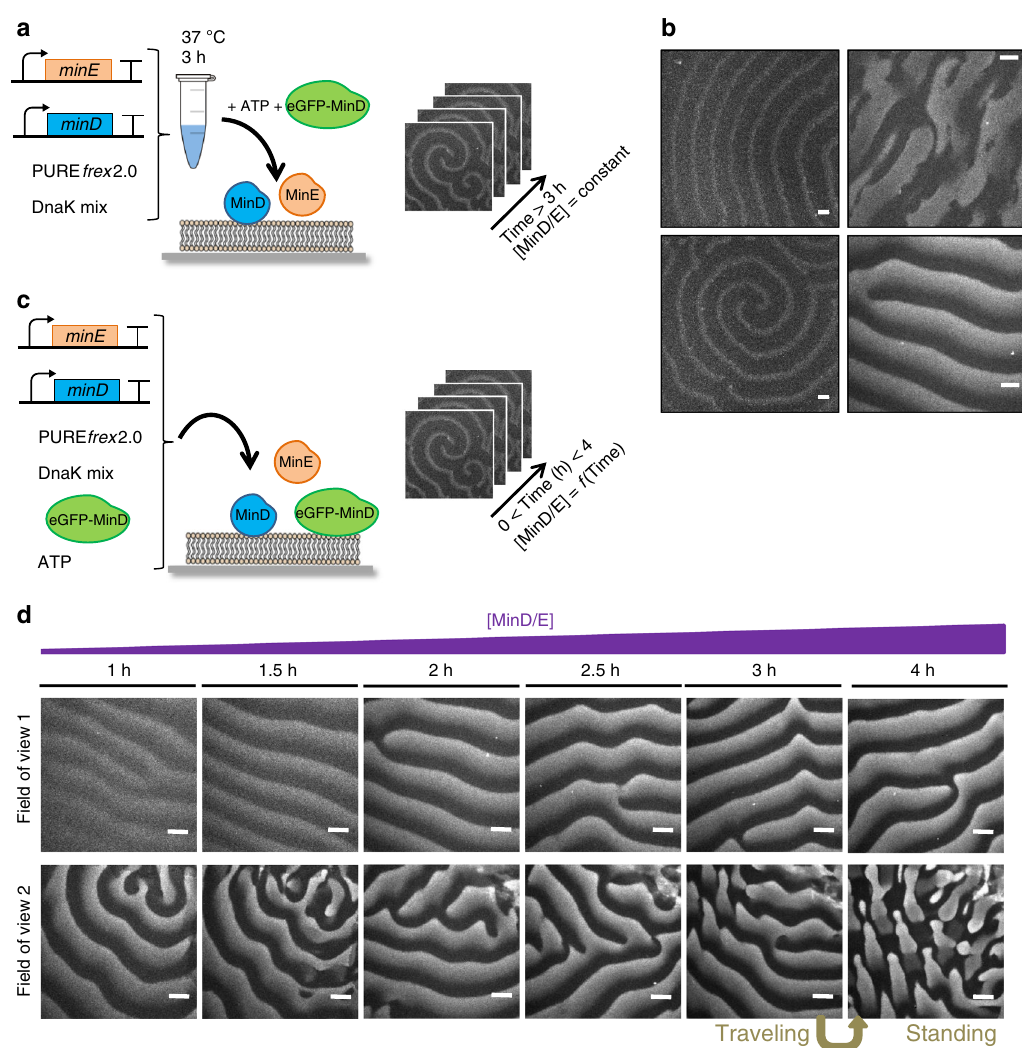
Fig. 2 Supported membrane assays with de novo synthesized MinD and MinE proteins. a Schematic of the experimental work fl ow for end-point expression assays. Both minD and minE genes are expressed in a PURE system reaction in the presence of DnaK chaperone mix for 3 h. The solution is then supplemented with 2.5 mM ATP and a trace amount of puri fi ed eGFP-MinD (100 nM) before transfer on top of a supported lipid bilayer. b Fluorescence microscopy images of representative types of MinDE dynamic patterns. Videos can be found in Supplementary Movie 1. Scale bars are 20 µ m. c Schematic illustration of the in situ MinDE co-expression and self-organization on an SLB. d Several SLB fi elds of view were imaged at different points during in situ co- expression of MinD and MinE proteins. Corresponding videos are shown in Supplementary Movie 2. Scale bars are 20 µ